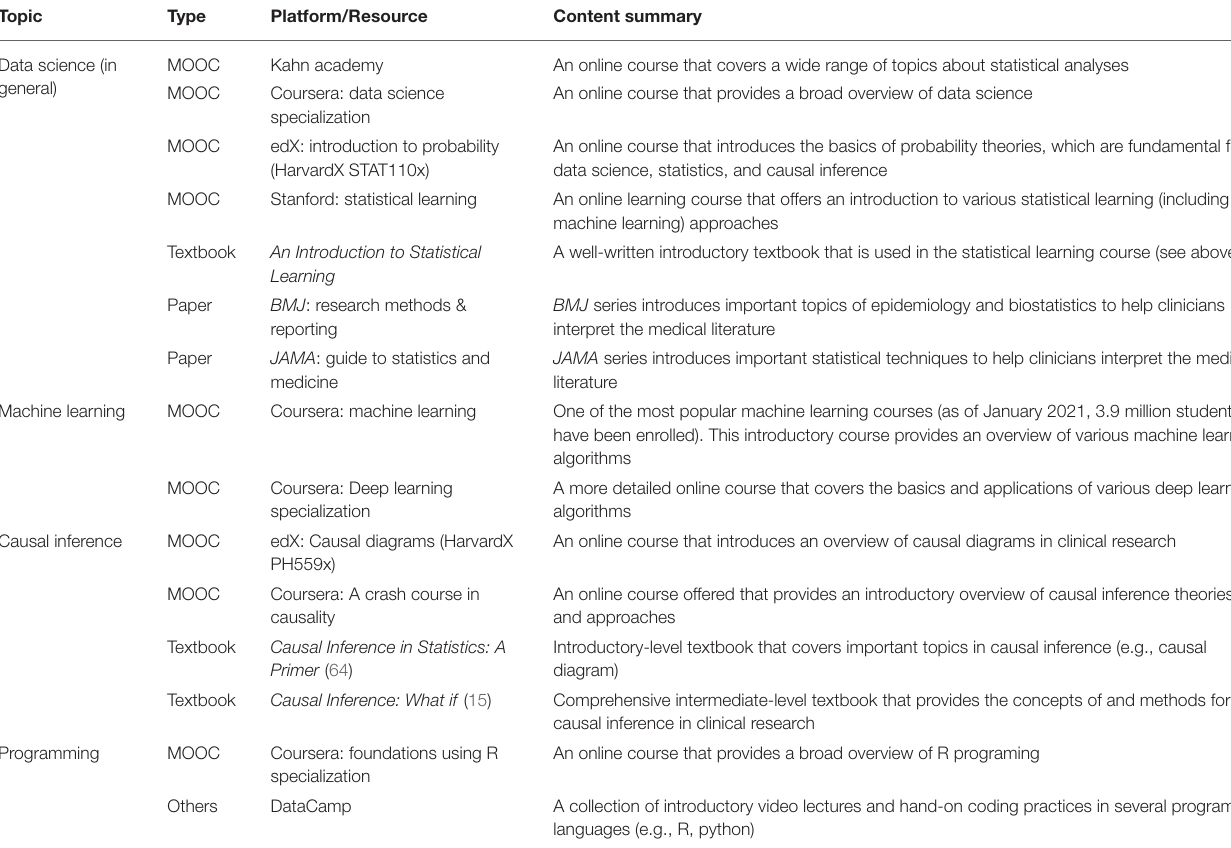
TABLE 4 | Twelve major resources for clinicians who wish to learn about data